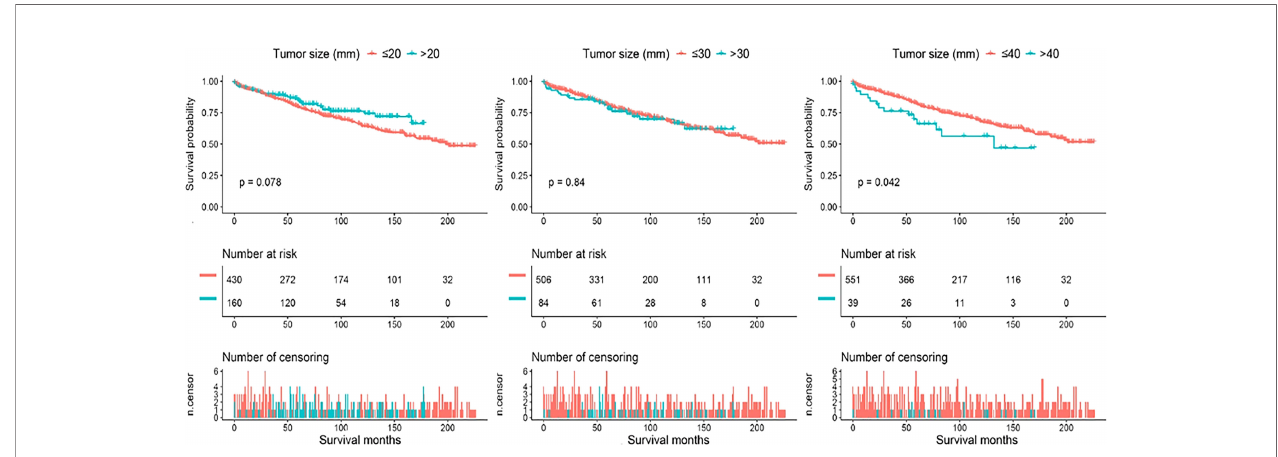
FIGURE 2 | Kaplan-Meier survival curves demonstrating survival disparity of overall survival by categorizing the parathyroid carcinoma population using different tumor size cutoffs. Tumor diameter cutoffs at 2 cm, 3 cm, and 4 cm were selected as splitting points to categorize tumor size. No signi fi cant survival difference was observed between 2 cm (Log-rank test P = 0.078) and 3 cm (Log-rank test P = 0.84) cutoff groups. However, the survival disparity became statistically evident at 4 cm in tumor size (Log-rank test P =